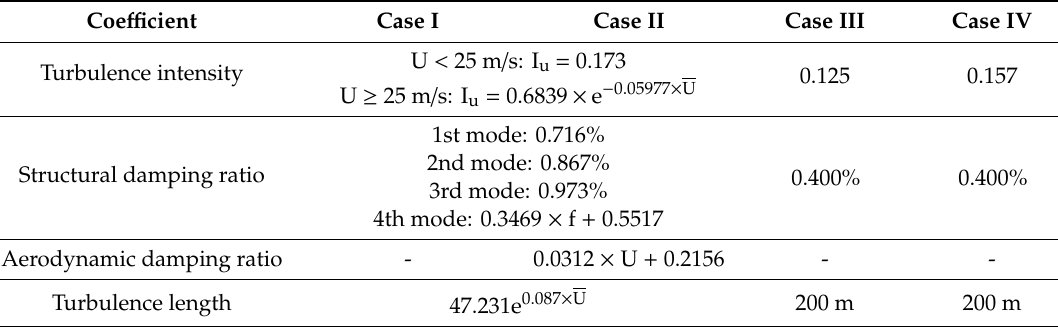
Figure 10. RMS of bu ff eting responses: ( a ) Responses at the center of the mid-span; ( b ) Responses at the quarter point of the mid-span. Table 7. Parameters for bu ff eting analysis.